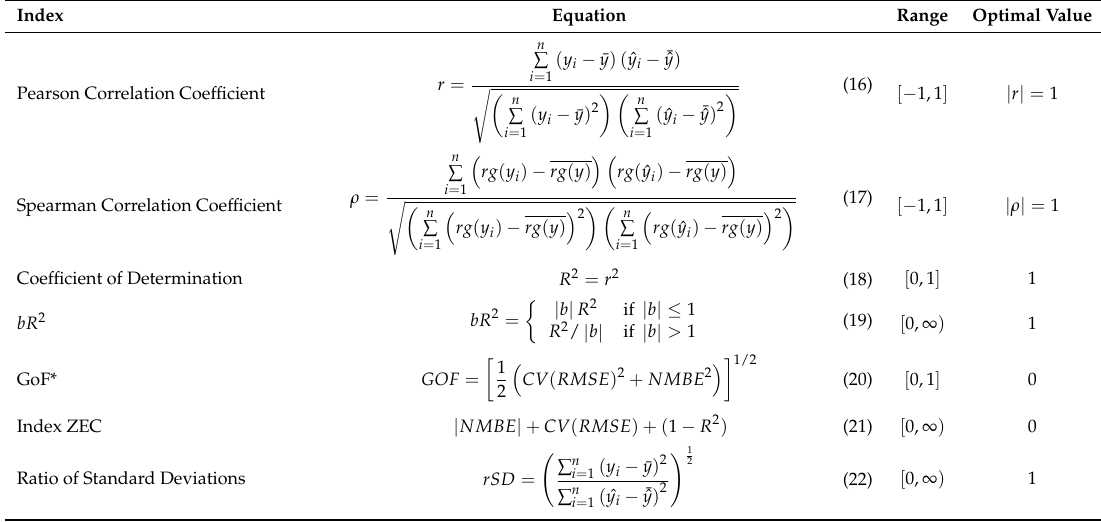
Table 4. Goodness-of-fit